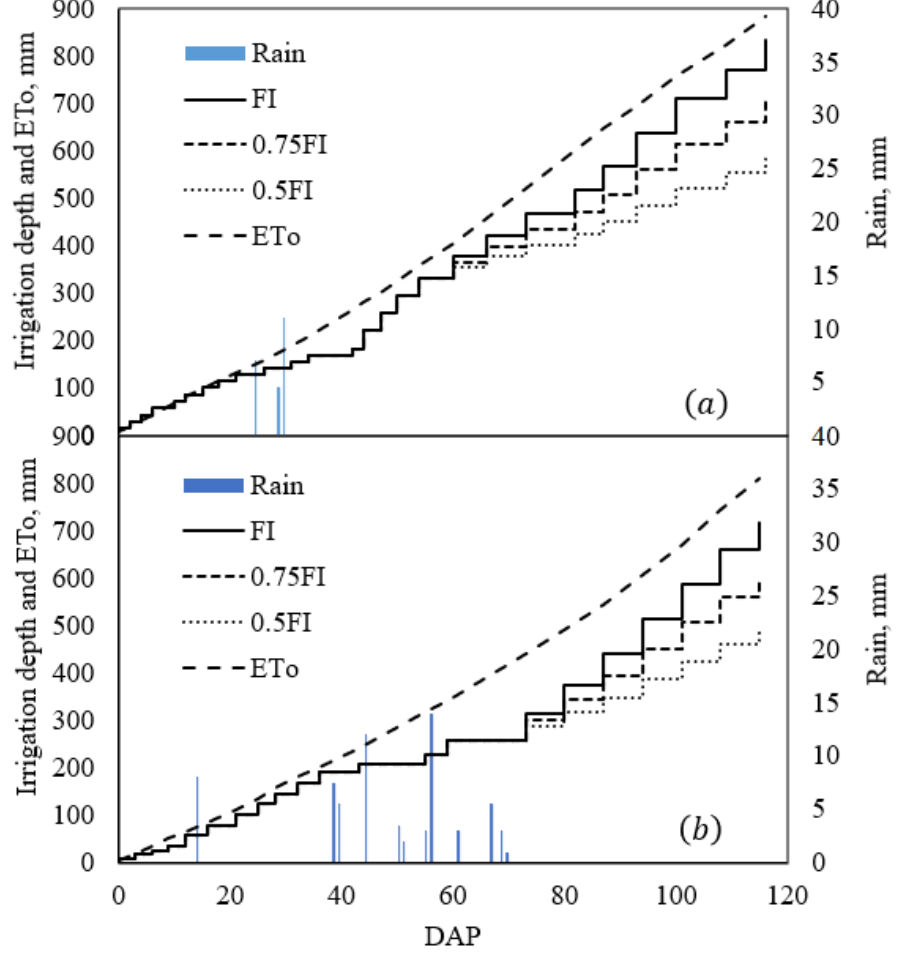
Figure 1. Irrigation depth, ET o , and rainfall during the quinoa growing season; ( a ) first year; ( b ) second year. DAP: days after planting.